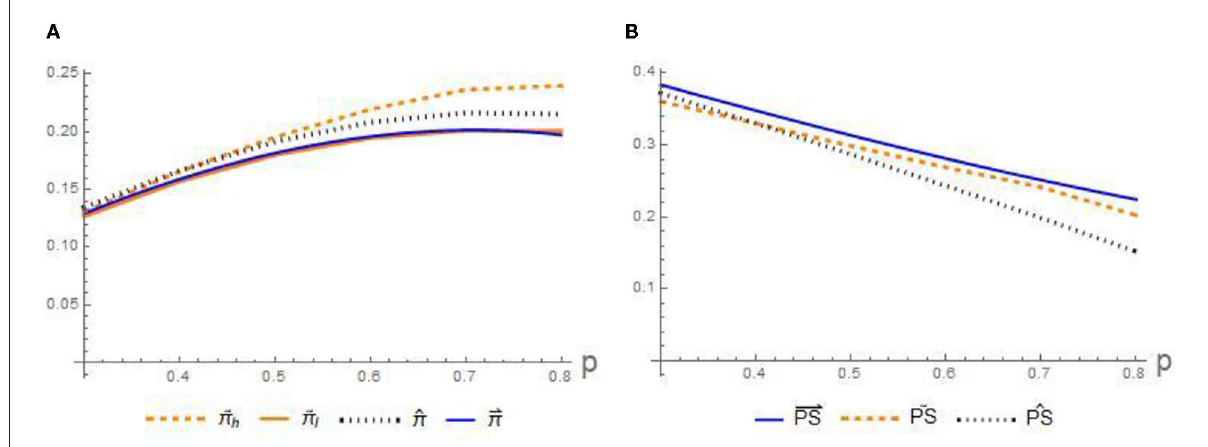
FIGURE4 Impact of signing fee on the profits on (A) profits π and (B) patients’ social welfare PS .